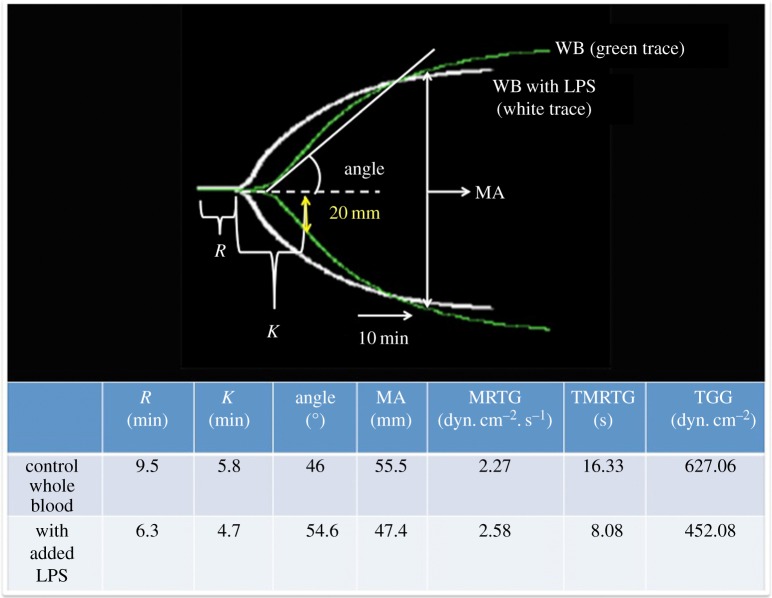
TEG overlay from a control whole blood sample with and without added LPS. R, reaction time, first measurable clot formation; K, achievement of clot firmness; angle, kinetics of clot development; MA, maximum clot strength; MRTG, maximum rate of thrombus generation; TMRTG, time to maximum rate of thrombus generation; TTG, final clot strength. (Online version in colour.)